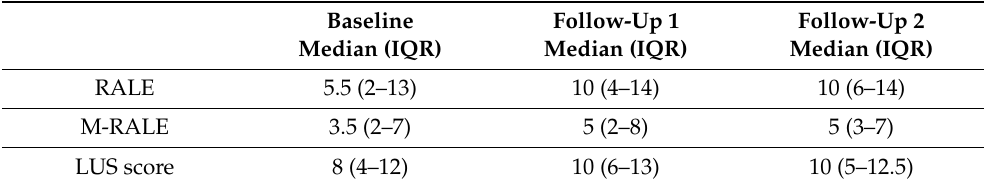
Figure 2. Study flow chart. Thirty patients fulfilled the inclusion criteria and were included in this prospective study. Twenty-six received at least one follow-up LUS and CXR.